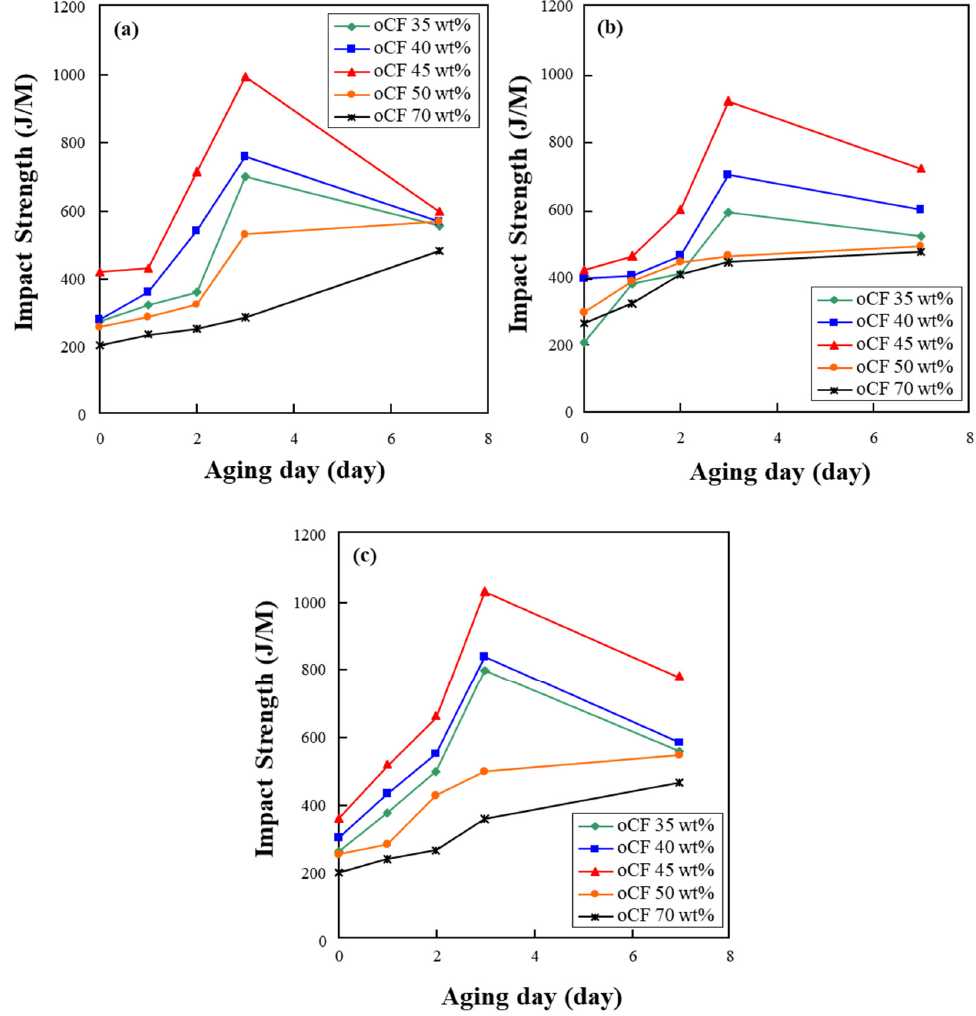
Figure 6. Variation in impact strength of oCFOCs by aging days: ( a ) HDPE, ( b ) LDPE, and ( c ) PP.